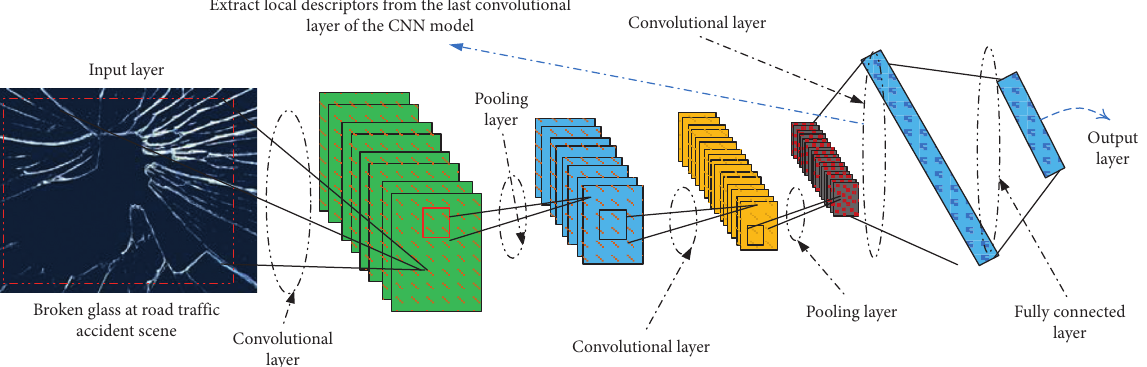
Figure 2: Extraction of local descriptors for the depth of broken glass cracks at the scene of a road traffic